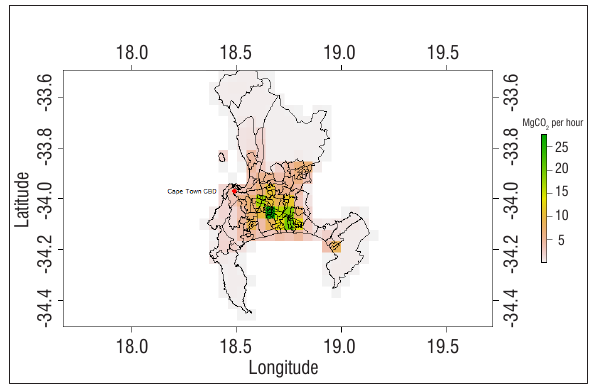
emissions from domestic fuel use du- Figure 4: Map of rasterised CO emissions from industrial point sources. Figure 6: Uncertainties in the CO 2 2 ring winter. Airport and harbour emissions Industrial emissions from scheduled activities The emissions from aircraft at the airport are on average 10 890 Mg The emissions resulting from industrial processes are distributed slightly of CO a month, with higher emissions during November to January 2 away from the CBD towards the outskirts of the city centre, spreading when air traffic increases into the city (Figure 7). The average hourly outwards towards the city boundaries (Figure 5). The largest per pixel emission from aircraft at the airport is 15.1 Mg of CO . This analysis emission was 57 Mg CO per hour, with an error value of 9 Mg CO per 2 2 2 does not include the emissions from point sources or ground vehicles hour, which is 16% of the mean value (Figure 6). at the airport and will require a count of each aircraft type arriving at the The advantage of obtaining the CO emissions by using the fuel data airport. The Defra guidelines for aircraft emissions supply the average 2 compared to converting the CO emissions for different industries is amount of time each ground unit spends in operation per LTO cycle for a that the error estimates are much smaller, as the fuel data have a much particular aircraft type, and these estimates could be used to determine smaller associated error than estimated CO emissions for a particular emissions from ground vehicles at the airport. industry. The disadvantage of the fuel data approach is that emissions The total emissions from shipping vessels in the Cape Town harbour, at from process-related activities are ignored, but would be included if the total CO emissions were converted into CO emissions. Both the berth and during manoeuvring procedures, are on average 4171.6 Mg 2 fuel data and the CO emission data are difficult to access and rely on of CO per month (Figure 8), which is approximately 5.8 Mg of CO per 2 2 accurate reporting from the industrial firms. hour. Emissions take a dip during the mid-winter months, when the seas around Cape Town are particularly rough and storms are prevalent. Total emissions To demonstrate the aggregation of the different source emission layers, the total emissions estimated for a weekday in March 2012 at 18:00 were obtained. The industrial emissions and power station emissions were assumed to take place at all times, so the same layer would be used regardless of which hour was of interest. March falls into the winter period, so the winter domestic emission layer was used, and because it was a weekday at 18:00, no scaling was necessary for the vehicle emissions layer. The airport and harbour emissions for March 2012 were used. The monthly value was divided equally between all hours of the month for harbour emissions and divided evenly between all days and the hours from 06:00 to 18:00 in the case of the airport emissions. These layers were summed and the resulting emission layer was mapped (Figure 9). emissions from industrial point sources. Figure 5: Map of rasterised CO 2 emissions per household 25 Table 2: Emission factors and fuel usage figures used to estimate the amount of CO 2 LPG Paraffin Wood Coal Emission factor 25 1530.1 kg CO per kL 2 Total amount used in summer per household